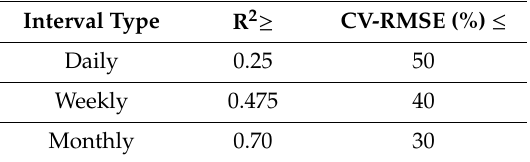
Table 2. Thresholds for heating use